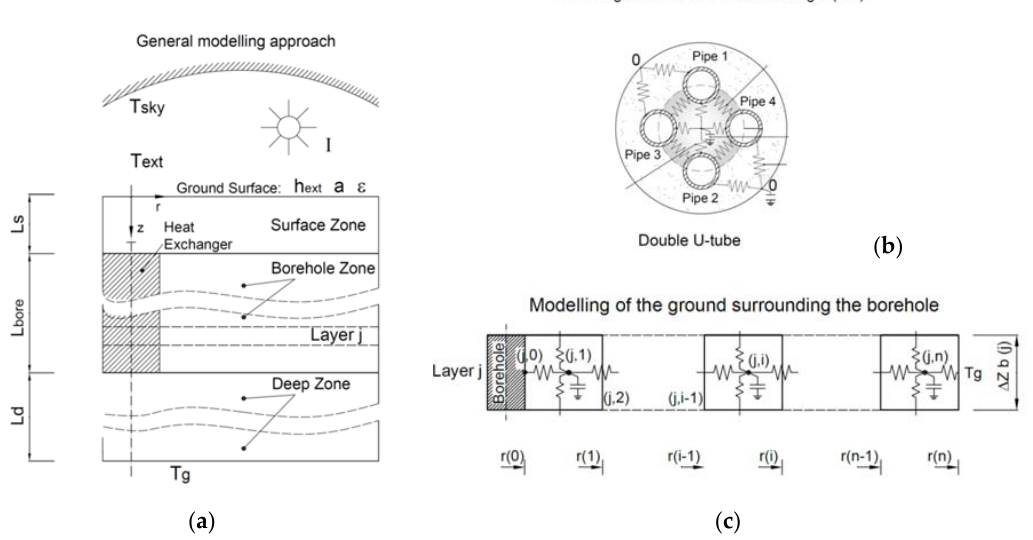
Figure 1. Scheme of the CaRM approach: ( a ) general concept, ( b ) modeling of the BHE, ( c ) modeling of the ground layer.